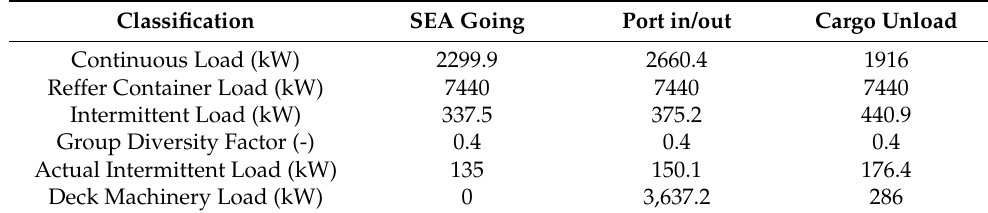
Table 2. List of electrical loads.